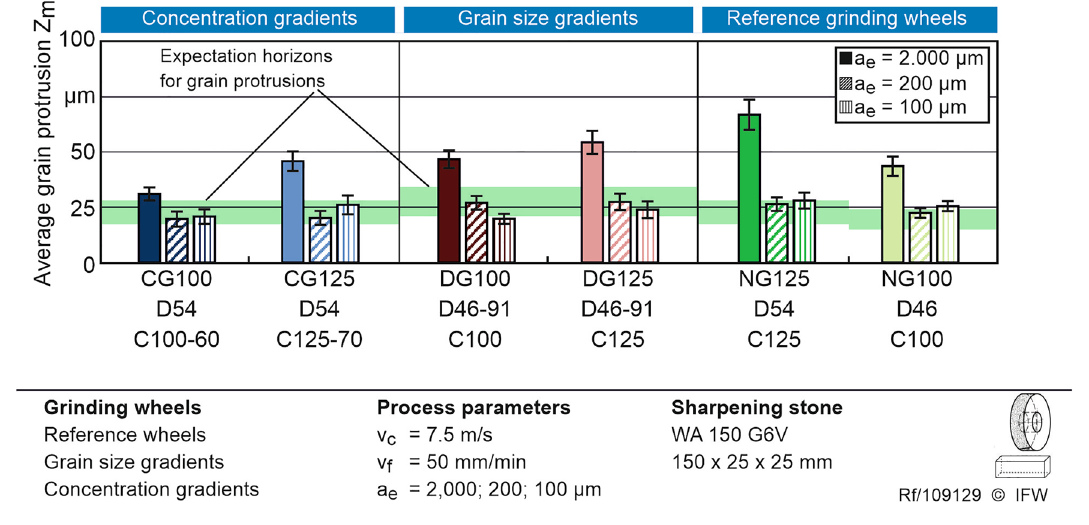
Fig.4 Influence of infeed on grain protrusions